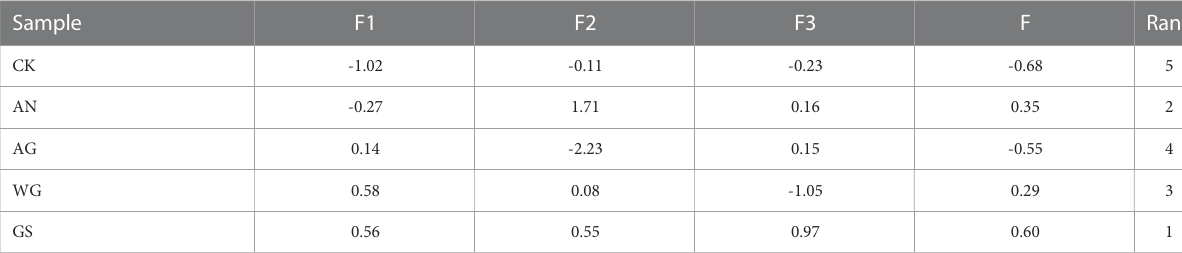
TABLE 4 Principal component scores after standardization.